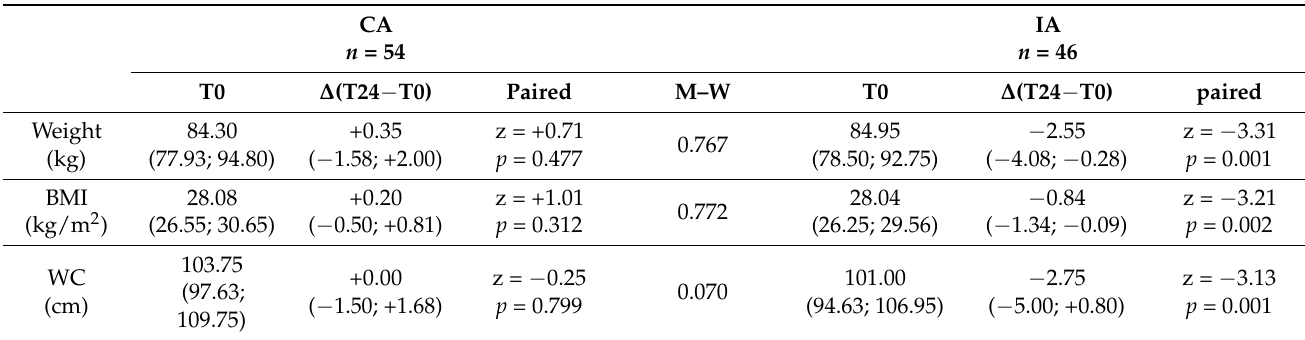
Table 2. Anthropometric measurements at baseline (T0) and at the end of 24 months of intervention